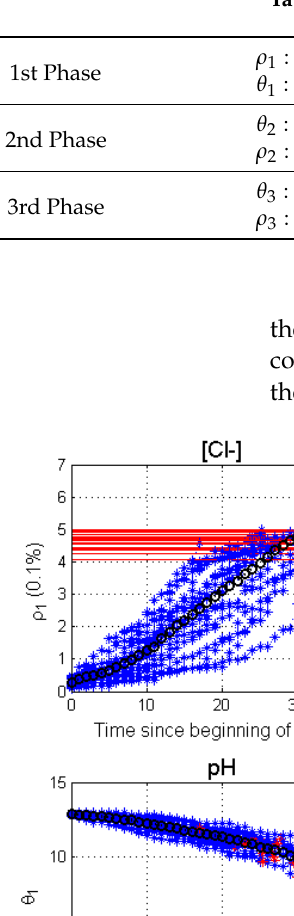
Table 2. Original parameters of the meta-model.